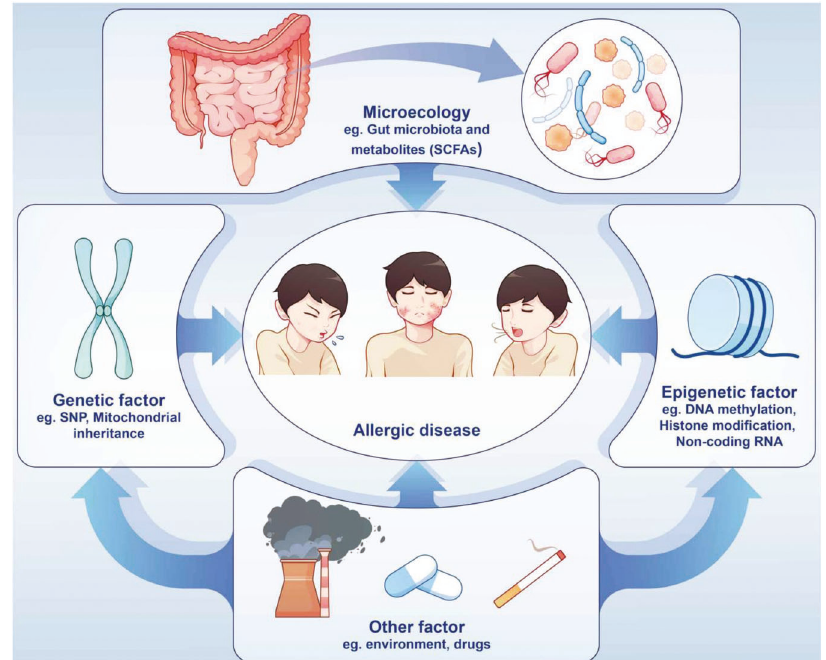
Fig. 2 Allergic diseases are caused by a variety of factors. External factors include changes in gut microbiota and metabolites, drugs, and air pollution. Internal in fl uencing factors include genetic and epigenetic changes Signal Transduction and Targeted Therapy (2023)